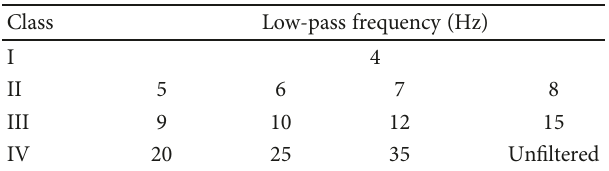
Table 2: Class-wise list of frequencies for low-pass EOG signal fi ltering used in this study. Class